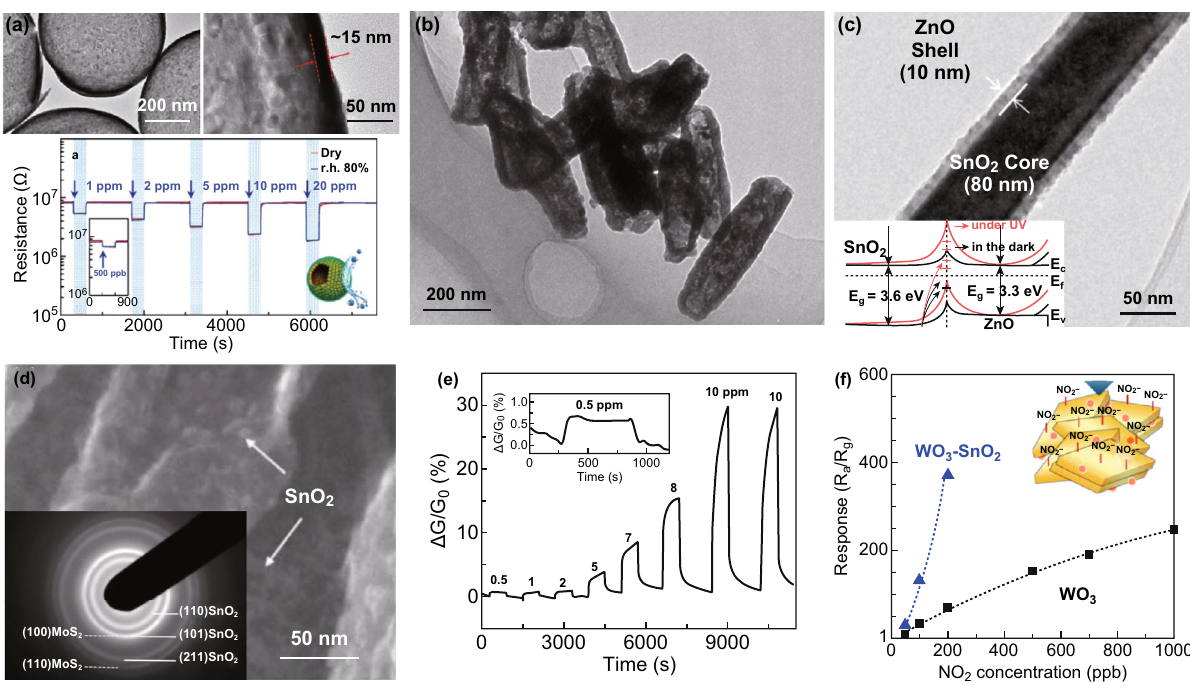
Fig. 11 a TEM images and dynamic sensing transients of Ce–In 2 O 3 hollow spheres exposed to 0.5–20 ppm of acetone at 450 °C in dry (red) and RH 80% (blue). Reproduced with permission [113]. Copyright 2016, Wiley–VCH. b TEM image of 1D Fe 2 O 3 /TiO 2 tube-like nanostruc- tures. Reproduced with permission [114]. Copyright 2012, American Chemical Society. c Low-magnification TEM image of SnO 2 /ZnO core– shell nanowires (the inset is the corresponding energy band diagram of the SnO 2 /ZnO system with/without UV light). Reproduced with per- mission [115]. Copyright 2013, American Chemical Society. d High-resolution SEM image showing that SnO 2 NCs decorate on the MoS 2 nanosheets (the inset is the corresponding SAED patterns), and e dynamic sensing response of the MoS 2 /SnO 2 nanohybrids to different NO 2 concentrations (the inset is the enlarged sensing response curve for 0.5 ppm NO 2 ). Reproduced with permission [116]. Copyright 2012, Wiley– VCH. f Schematic of the sensing mechanism of WO 3 –SnO 2 nanoplates and the corresponding responses comparison toward NO 2 gas. Repro- duced with permission [117]. Copyright 2014, American Chemical Society. (Color figure